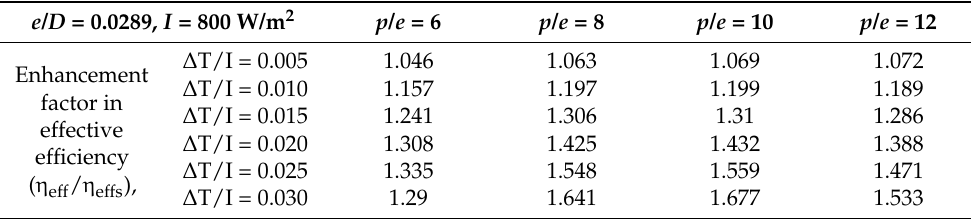
Table 5. Enhancement factor for effective efficiency at different relative rib pitches.